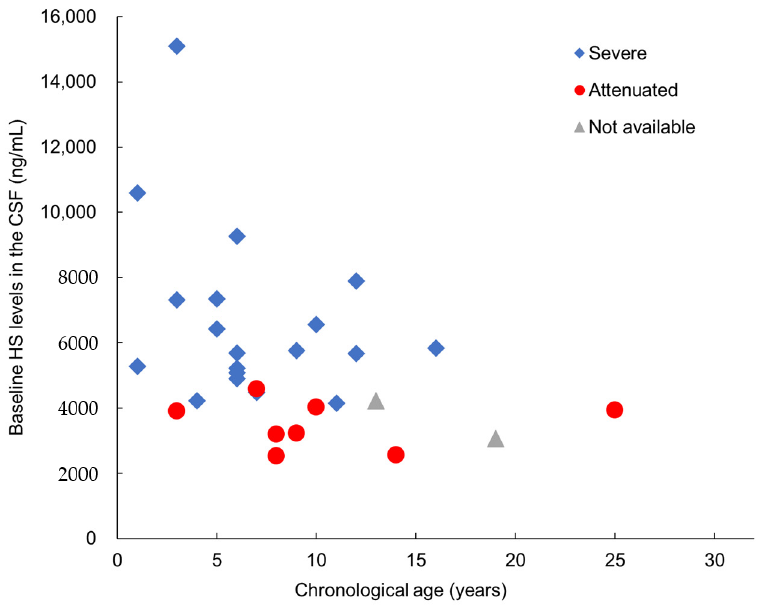
Figure 6. Baseline HS concentrations in the CSF of the 29 patients in the phase II/III clinical trial of pabinafusp alfa (modified from [27]).